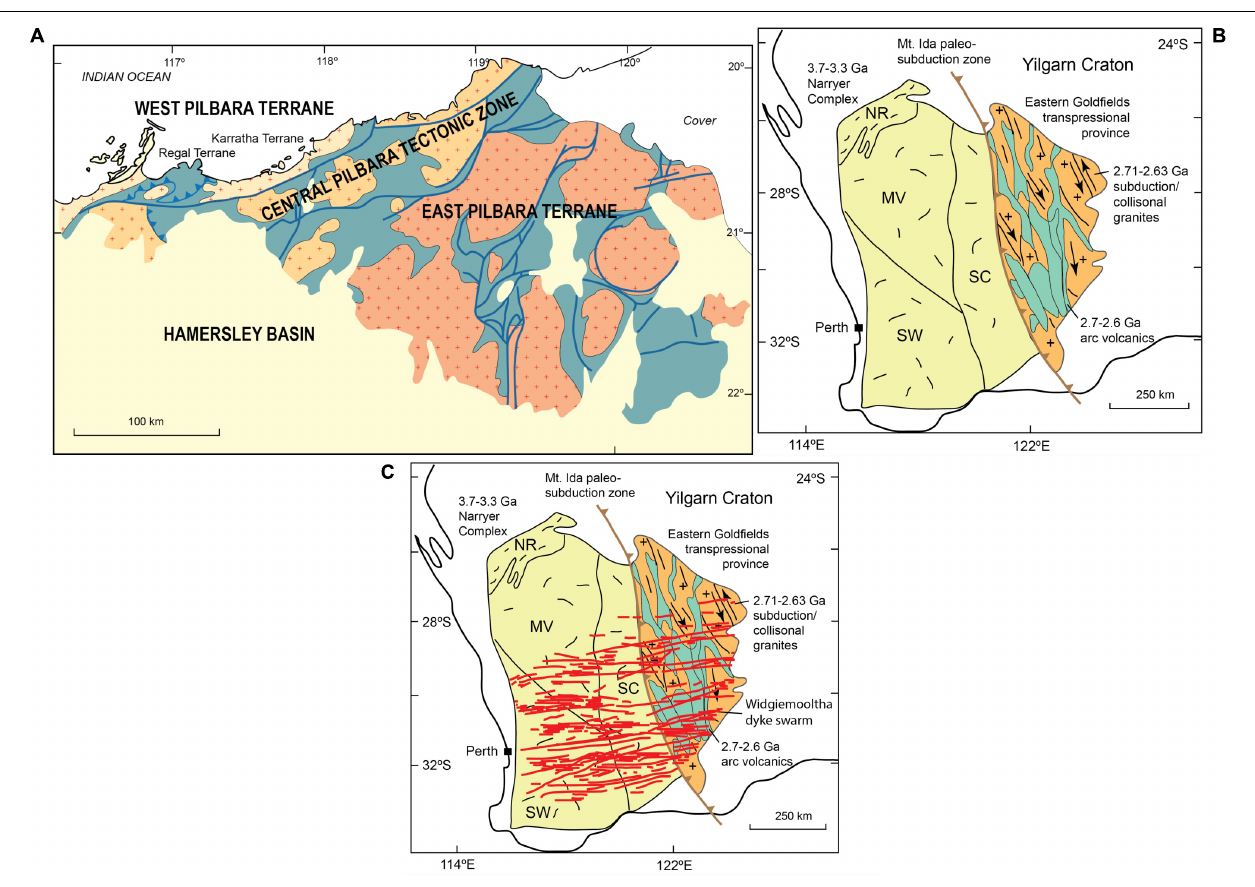
FIGURE 2 | The changing tectonic styles from 3.5 to 2.4 Ga in Western Australia. (A) A sketch map of the dome and basin terrain of Pilbara in NW Australia, after Hickman (2004) and Van Kranendonk (2010) (B) geological sketch map of the Yilgarn craton and the N-S trending mobile belts in the East Yilgarn (after Kusky et al., 2018), and (C) a map of the Widgiemooltha dyke swarm in the SW